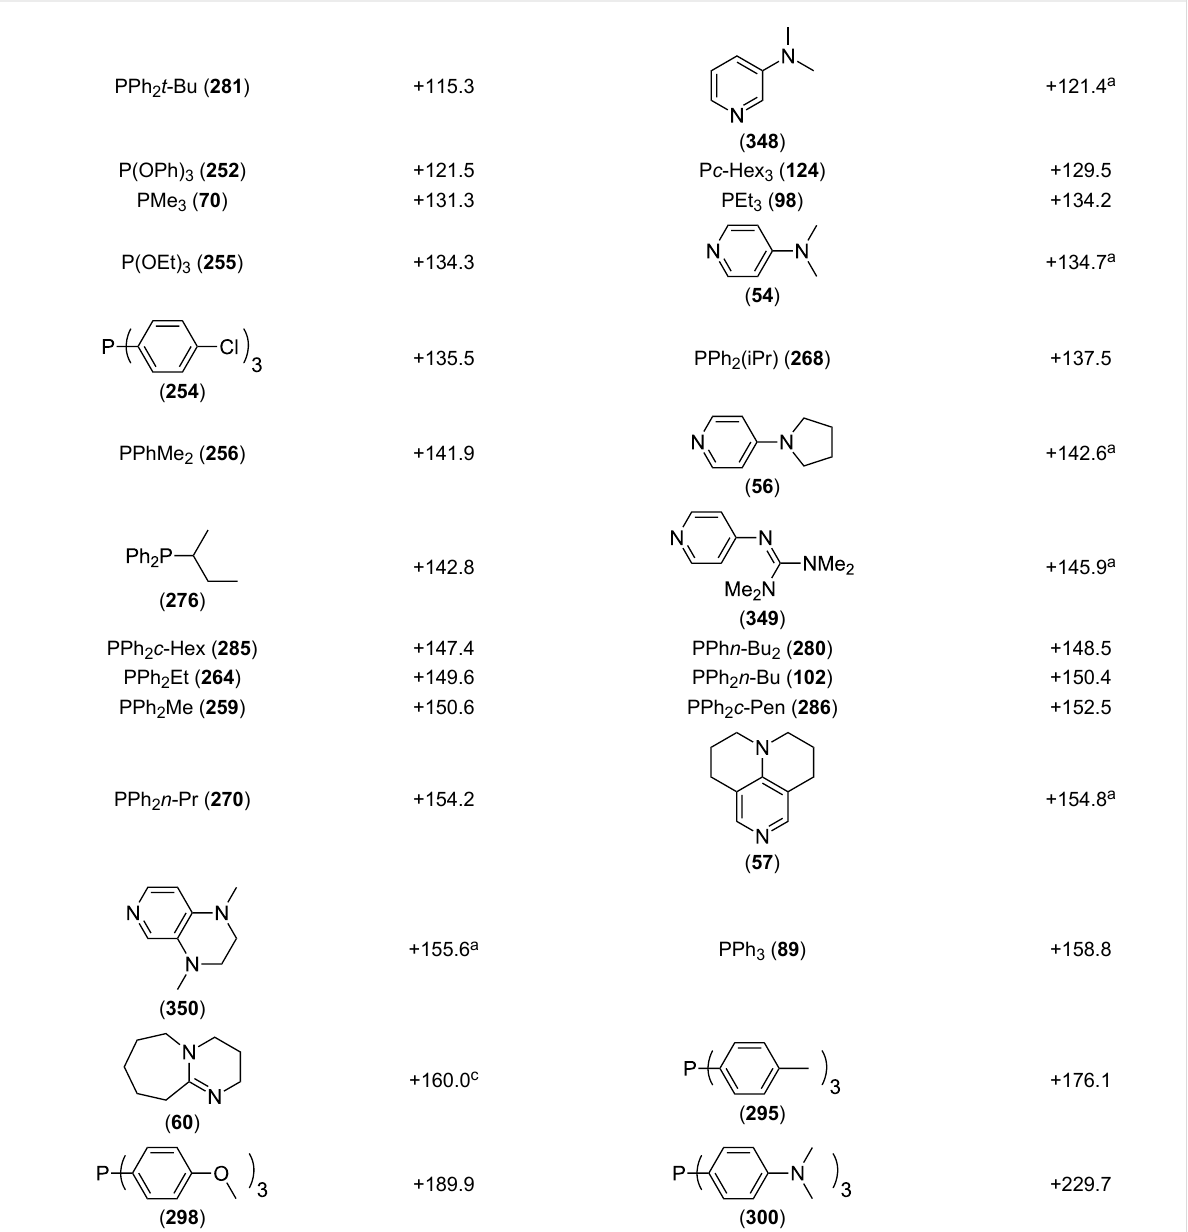
Table 10: TCA values of Lewis bases, ordered by increasing TCA values.